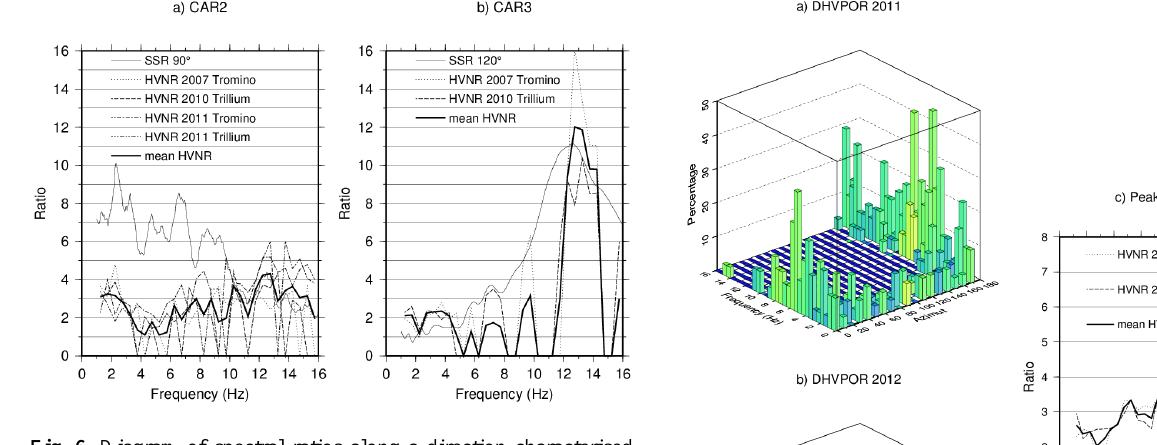
Fig. 6 - Diagram of spectral ratios along a direction characterised by a high recurrence of significant directional maximum at site CAR2 (a) and CAR3 (b). Thin solid line represents the SSR values obtained along the azimuths specified in legend; other lines represent mean values of noise H/V peaks having the same directions and frequencies binned by 0.5 Hz intervals, resulting from different HVNR measurements (see legend); thick solid line represents the average of noise H/V peak values derived from the HVNR measurements.